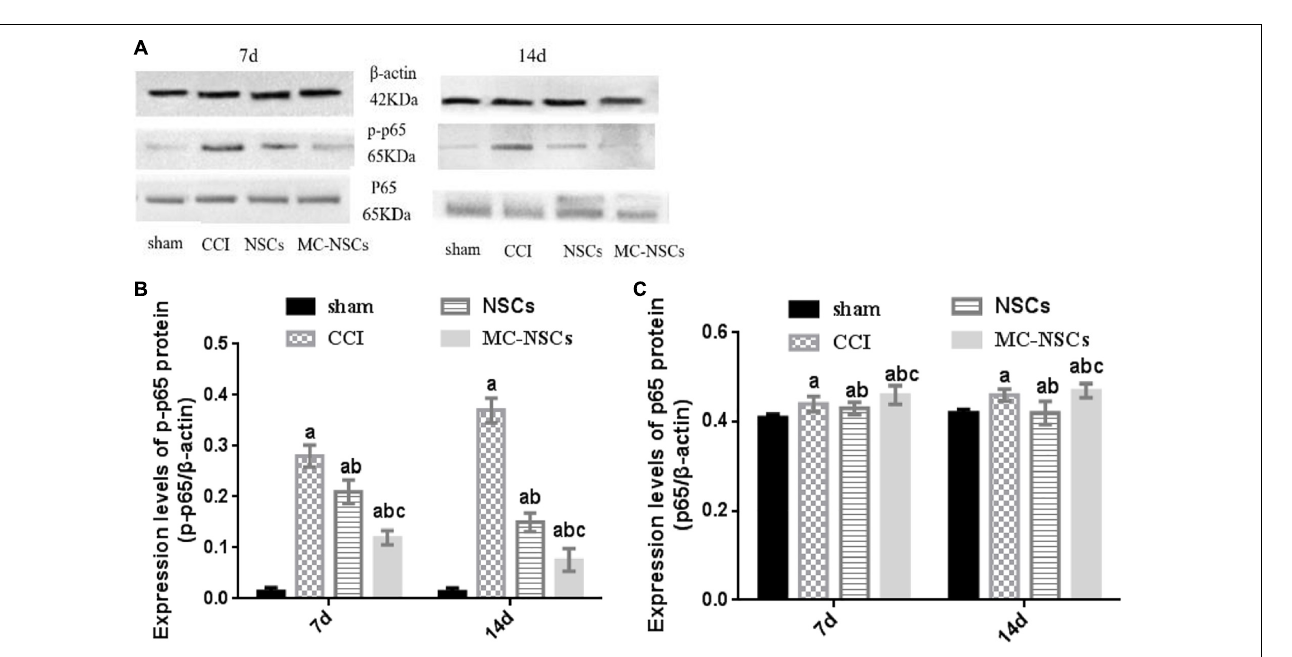
FIGURE 8 | Results of p-p65 and p65 protein expression. (A) Western blotting was performed to measure the expression of p65 and p-p65 protein. (B,C) The integrated optical density (IOD) of p-p65 from high to low was found in the CCI, NSCs, MC-NSC, and sham groups. Compared with the NSCs group, the IOD of p-p65 in the MC-NSCs group was decreased (p < 0.05). However, there was no significant change in the IOD of total p65 in each group (p > 0.05). Data were expressed as the mean ± SD of three replicates ( n = 6). a p < 0.05 vs. sham group; b p < 0.05 vs. CCI group; c p < 0.05 vs. NSC